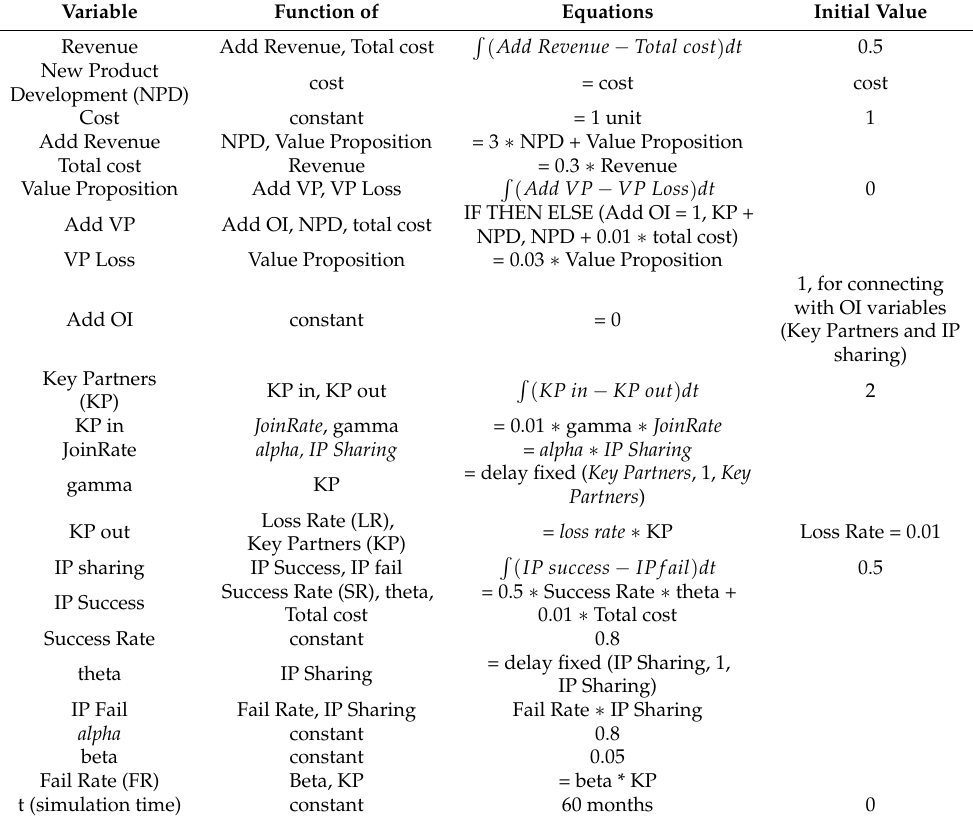
Table 4. System Dynamic Equations and Initial Value.